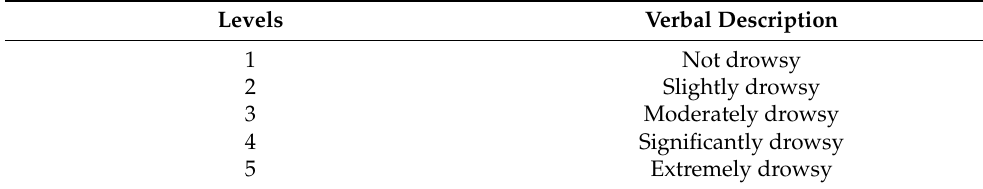
Table 2. Wierwille and Ellsworth drowsiness